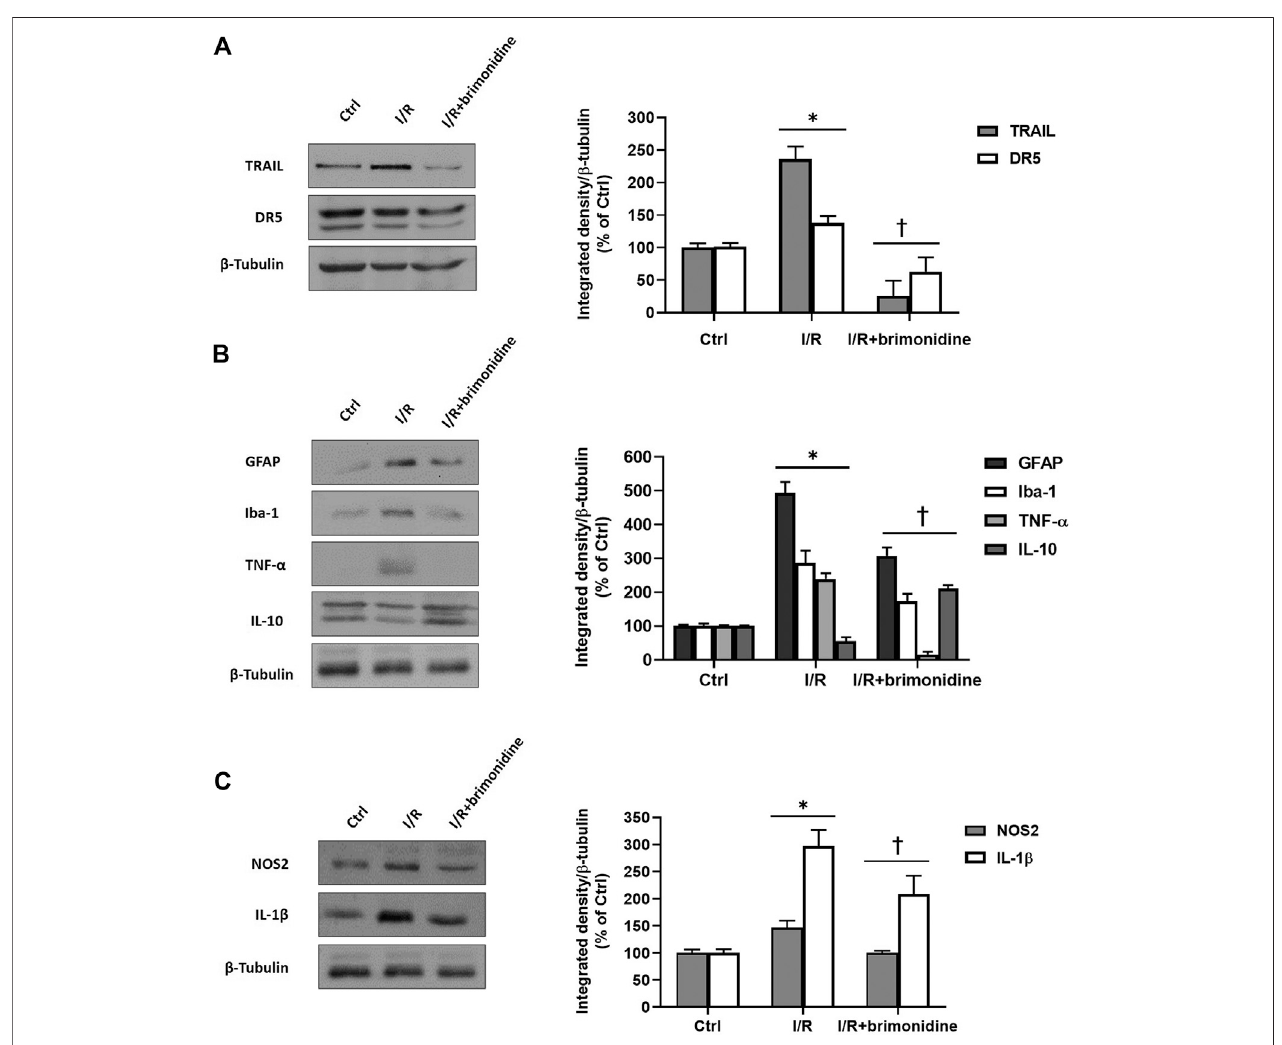
FIGURE 3 | Western Blot. (A) TRAIL and DR5 protein levels in control, I/R and brimonidine-treated mice retina; (B) GFAP, Iba-1, TNF- α and IL-10 proteins in mice retina w or w/o brimonidine; (C) NOS2 and IL-1 β proteins in mice retina w or w/o brimonidine. Values represent protein expression relative to β -tubulin, used as housekeeping protein. Values are reported as mean ± SD ( n (cid:2) 5). One-way ANOVA analysis was performed followed by the Tukey post-hoc test. * p < 0.05 vs. Ctrl; † p < 0.05 vs.